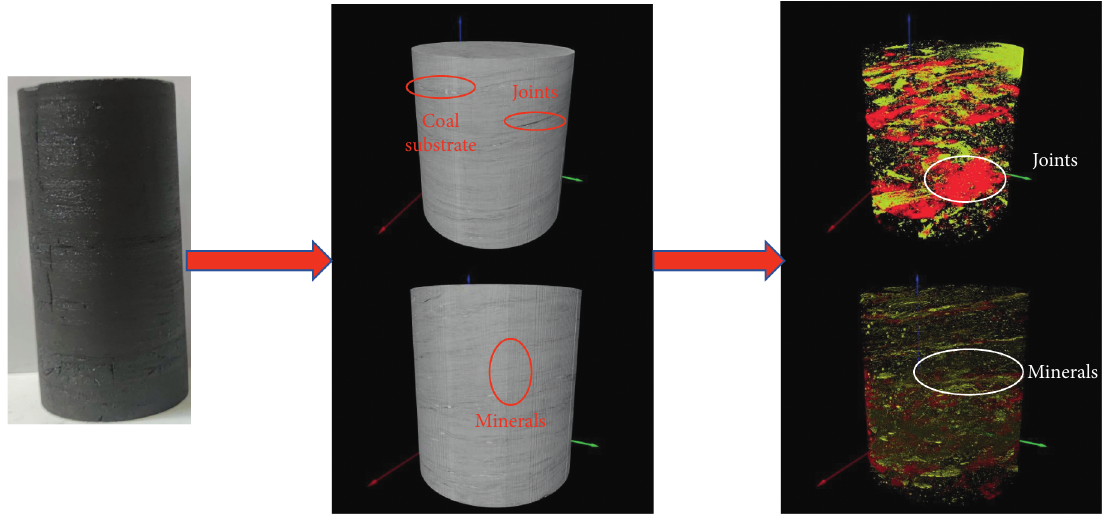
Figure 3: CT scan results of coal